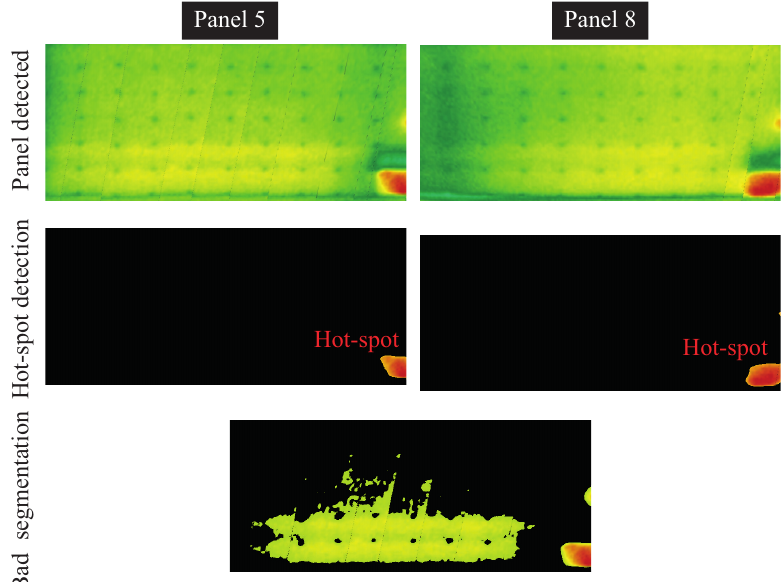
Figure 16. Results of Salazar’ algorithm applied to different PV-modules. Figure shows the photovoltaic module under study and the hot-spot analysis.